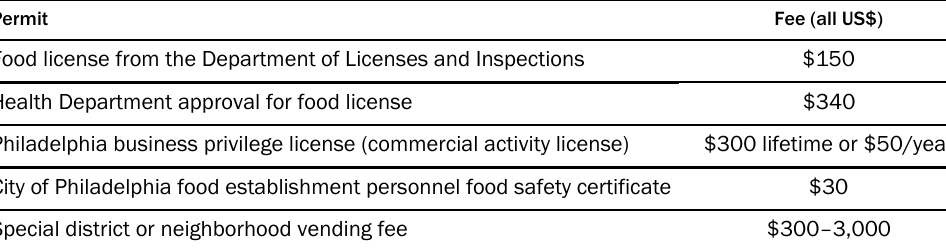
Table 2. Annual Fees and Permits for Curbside Whole-Produce